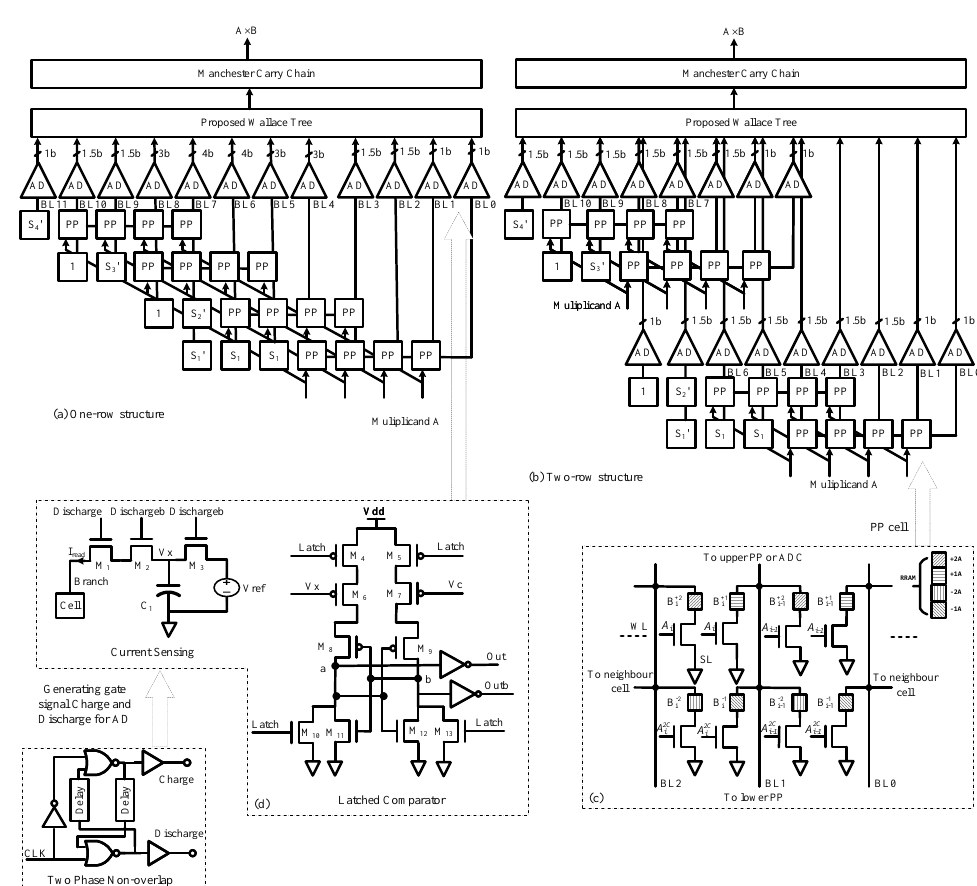
Figure 2. One-row and two-row multiplier circuits with relevant critical components. The proposed 8-bit radix-4 non-volatile parallel multiplier has two kinds of structures: one-row structure and two-row structure. Both two kinds of structures consist of partial product (PP) generator array, AD, simplified Wallace tree, and Manchester carry chain. ( a ) Two-row structure of the proposed multiplier with 2 kinds of AD. ( b ) One-row structure of the proposed multiplier with 4 kinds of AD. ( c ) The key components of the Wallace tree including adders and compressors. ( d ) The cell of partial product generator array. ( e ) The read-out circuit (AD1.5b). AD contains the current sensing circuit and latched comparator. A two-phase non-overlap clock circuit is needed to generate gate signal Charge and Discharge.